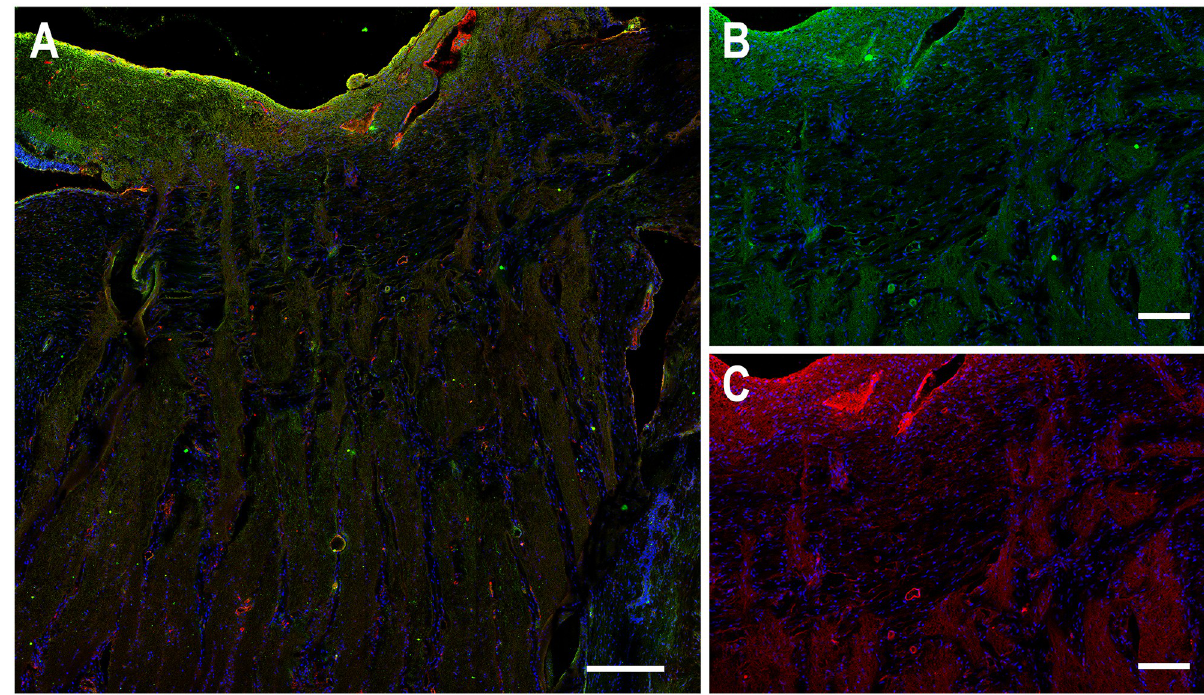
Fig 2. Longitudinal sections of porcine optic nerve head labeled for aquaporin 1 (AQP1, red) and aquaporin-9 (AQP9, green) and DAPI (blue). Labeling of AQP1 and AQP9 was substantial at the internal limiting membrane (A), but minimal throughout the lamina and myelinated optic nerve, except in the walls of larger blood vessel walls as seen in higher power images (B, C). Scale Bar: 100 μ m (A), 50 μ m (B, C).